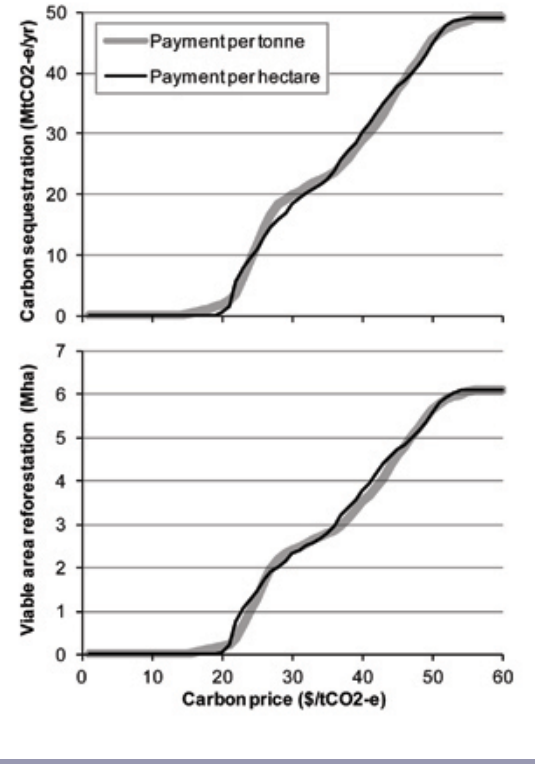
Fig. 3 . Economically viable area for reforestation and carbon sequestration supply curve under a range of carbon prices for the median scenario (R = 0.8, ec = A$2000/ha, tmc = A$70/ha/yr, r = 7%). Carbon sequestration is an annual average value over 64